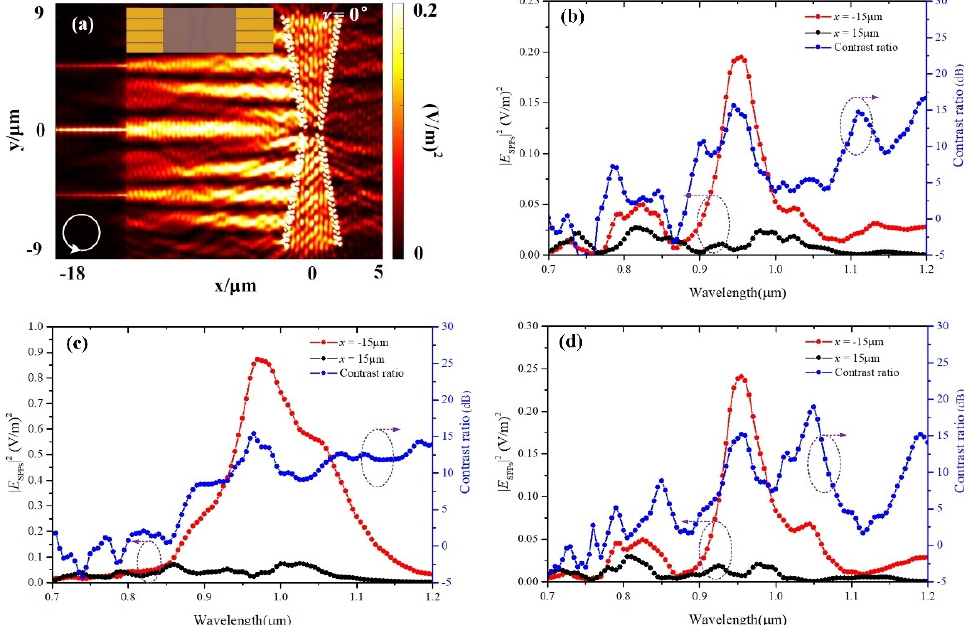
Figure 11. ( a ) The coupling effect of three nondiffracting SPP beams to three PMMA SPP waveguides when the inclined incidence angle is 0°. The inset in ( a ) is the structure scheme of the routing device. ( b ) The SPP intensity contrast ratio between the points ( − 15.5 µ m, 4.6 µ m) and (15.5 µ m, 4.6 µ m) in the incident wavelength range of 700 to 1200 nm. ( c ) The SPP intensity contrast ratio between the points ( − 15.5 µ m, 0.09 µ m) and (15.5 µ m, 0.09 µ m) in the incident wavelength range of 700 to 1200 nm. ( d ) The SPP intensity contrast ratio between the points ( − 15.5 µ m, − 4.5 µ m) and (15.5 µ m, − 4.5 µ m) in the incident wavelength range of 700 to 1200 nm. The red and black lines represent the SPP intensity, and the blue line represents the SPP intensity contrast ratio.